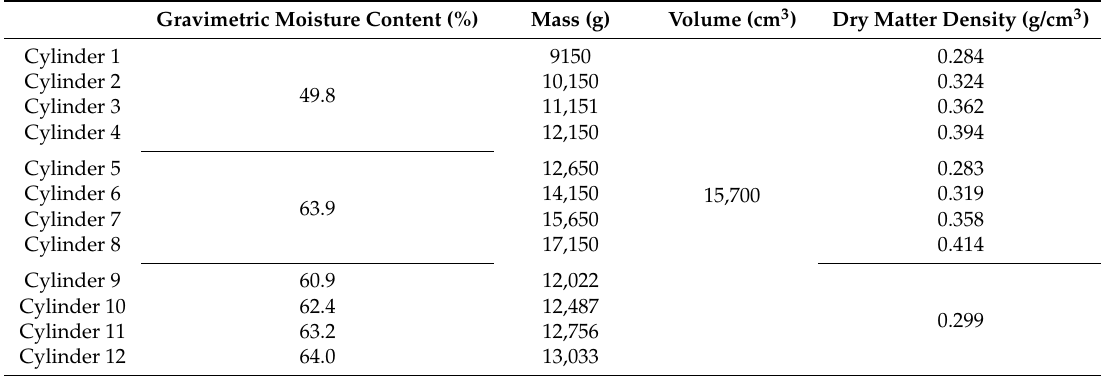
Table 1. Sample Information.